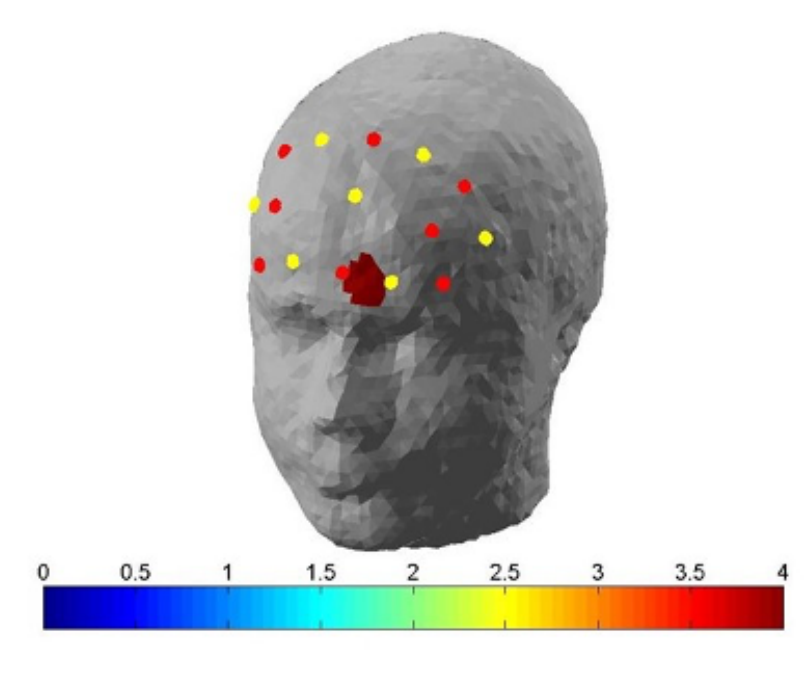
Topographical map of outside of domestic environment (OE) condition–domestic environment (DE) contrast. Topographical map depicting higher OxyHB concentration in channel 11 during response to sounds in the OE, as compared to the DE condition. This channel was located in the left rostrolateral prefrontal